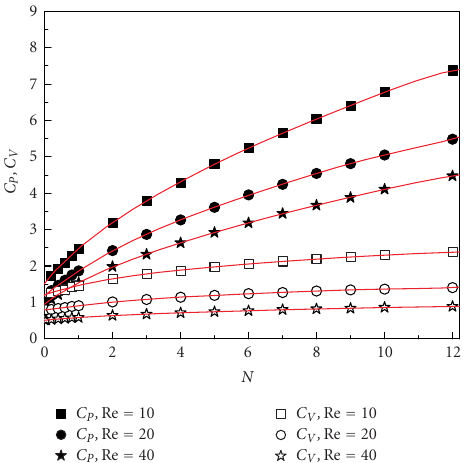
Figure 4.13 . Variation of viscous drag coe ffi cient C V and pressure drag coe ffi cient C P as a function of interaction parameter N